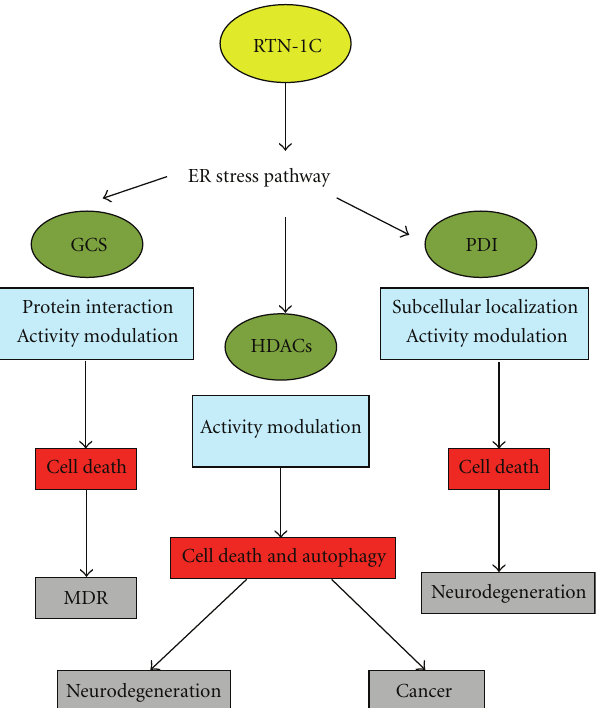
Figure 2: Schematic representation of the di ff erent RTN-1C- induced signaling pathways. Modulation of RTN-1C expression triggers the ER stress pathway and the regulation of di ff erent proteins (green ovals) at di ff erent levels (blue boxes). These events a ff ect cellular processes (red boxes) which are at the basis of several human pathological settings (grey